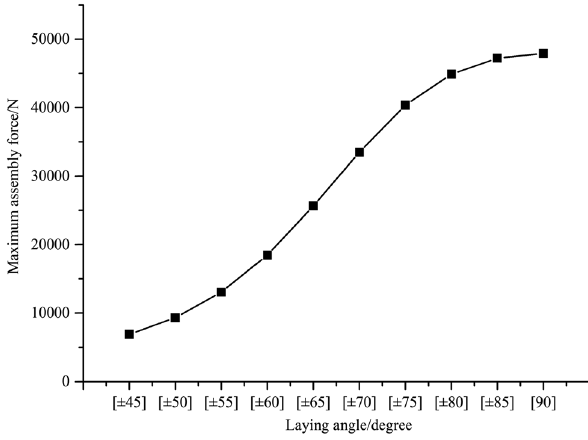
Figure 9: Relationship between maximum assembly force and laying angles.